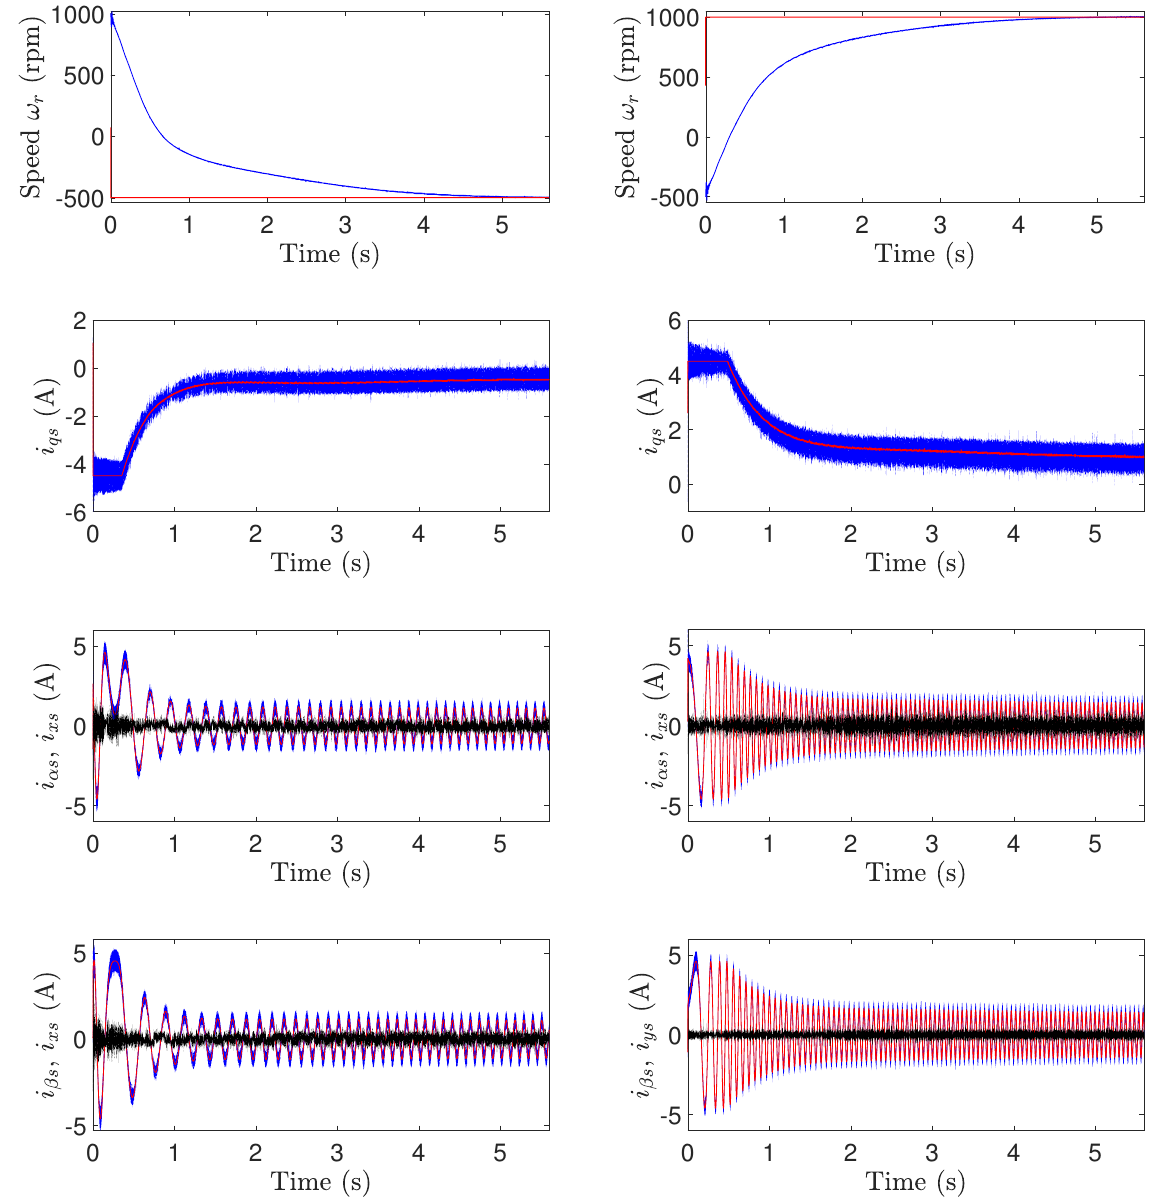
Figure 6. Transient response of { q , α , x , β , y } stator currents for two different desired step rotor speeds ω d r with a variation of 25% on the magnetizing inductance: results from 1000 to − 500 rpm in the left column and from − 500 to 1000 rpm in the right